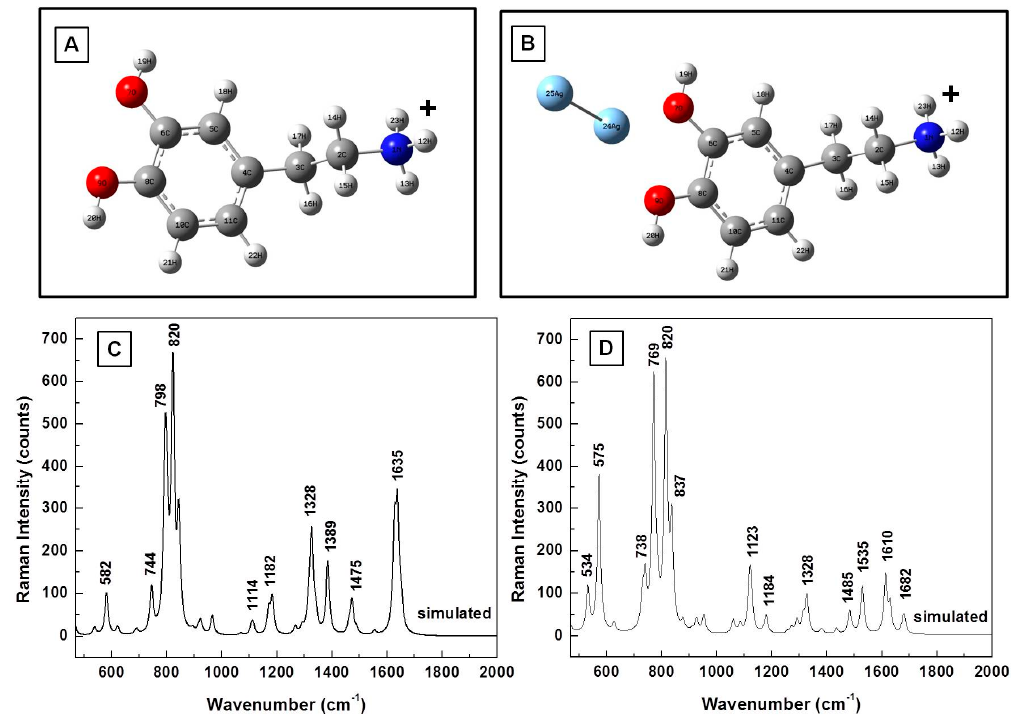
Figure 5. ( A , B ) Structural representations of the cationic form of dopamine without and with the silver dimer, respectively; ( C , D ) Theoretically calculated Raman vibrations of DA + alone and in the proximity of silver, respectively.